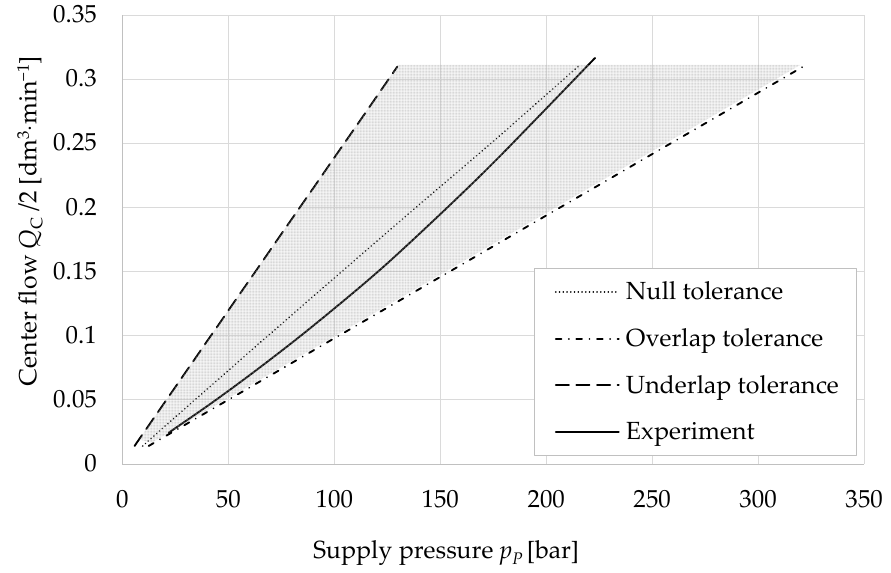
Figure 12. Numerically simulated center flow curves and experimentally determined center flow curve.